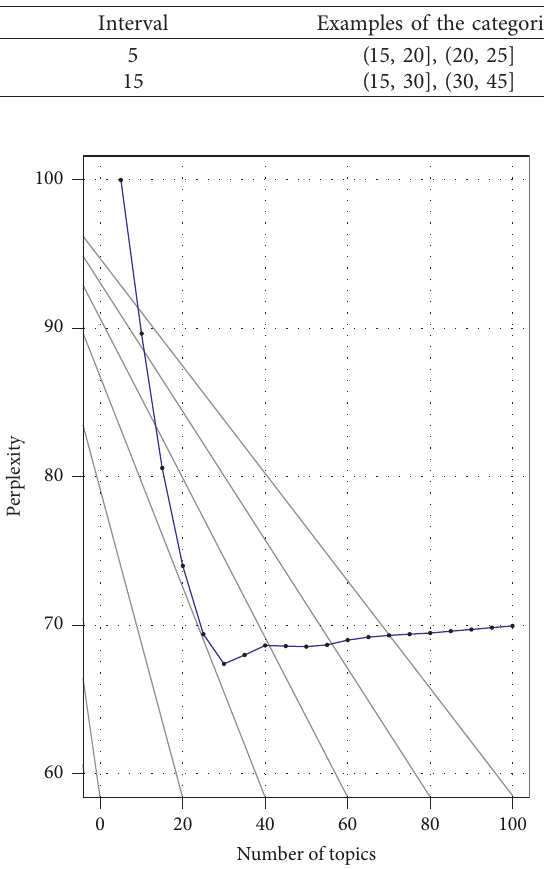
Figure 5: Perplexity versus the number of latent